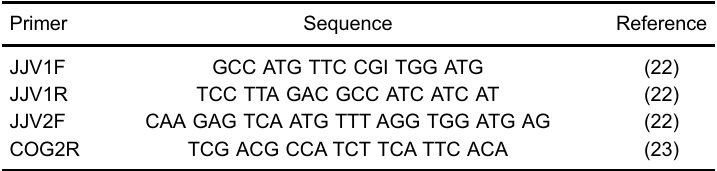
Table 1. Primers used in the